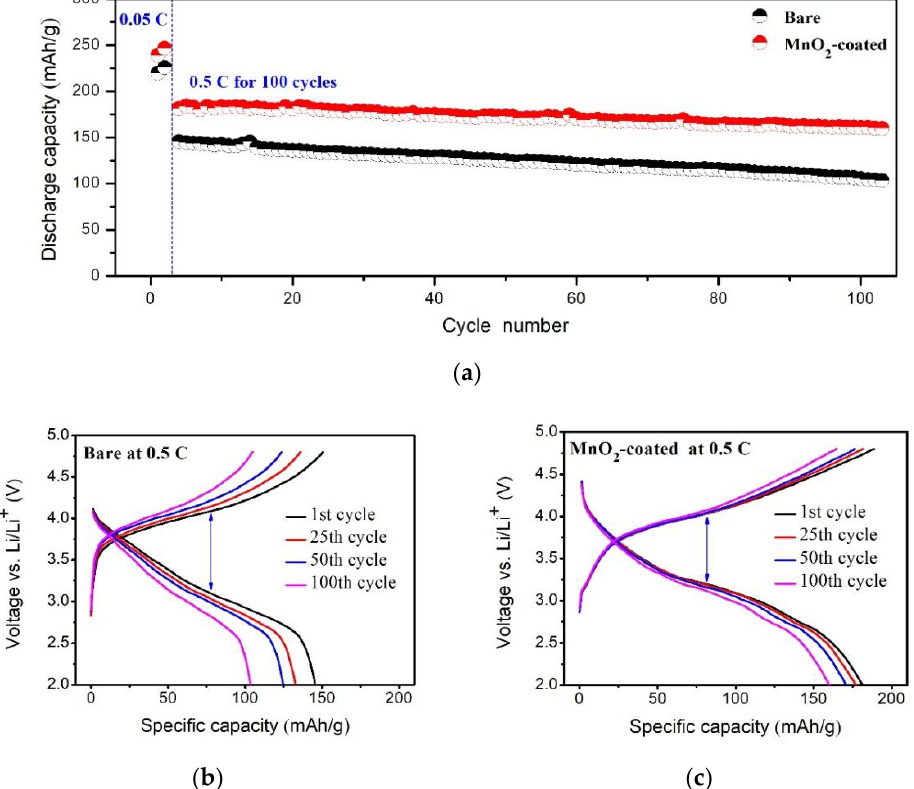
Figure 6. ( a ) Cyclic performance at 0.5 C. Charge and discharge curves of the ( b ) bare LTMO and ( c ) MnO 2 -coated LTMO for different cycles. Table 3. Comparison of the data of MnO 2 with other metal oxides reported as coating materials for LTMO. Coating